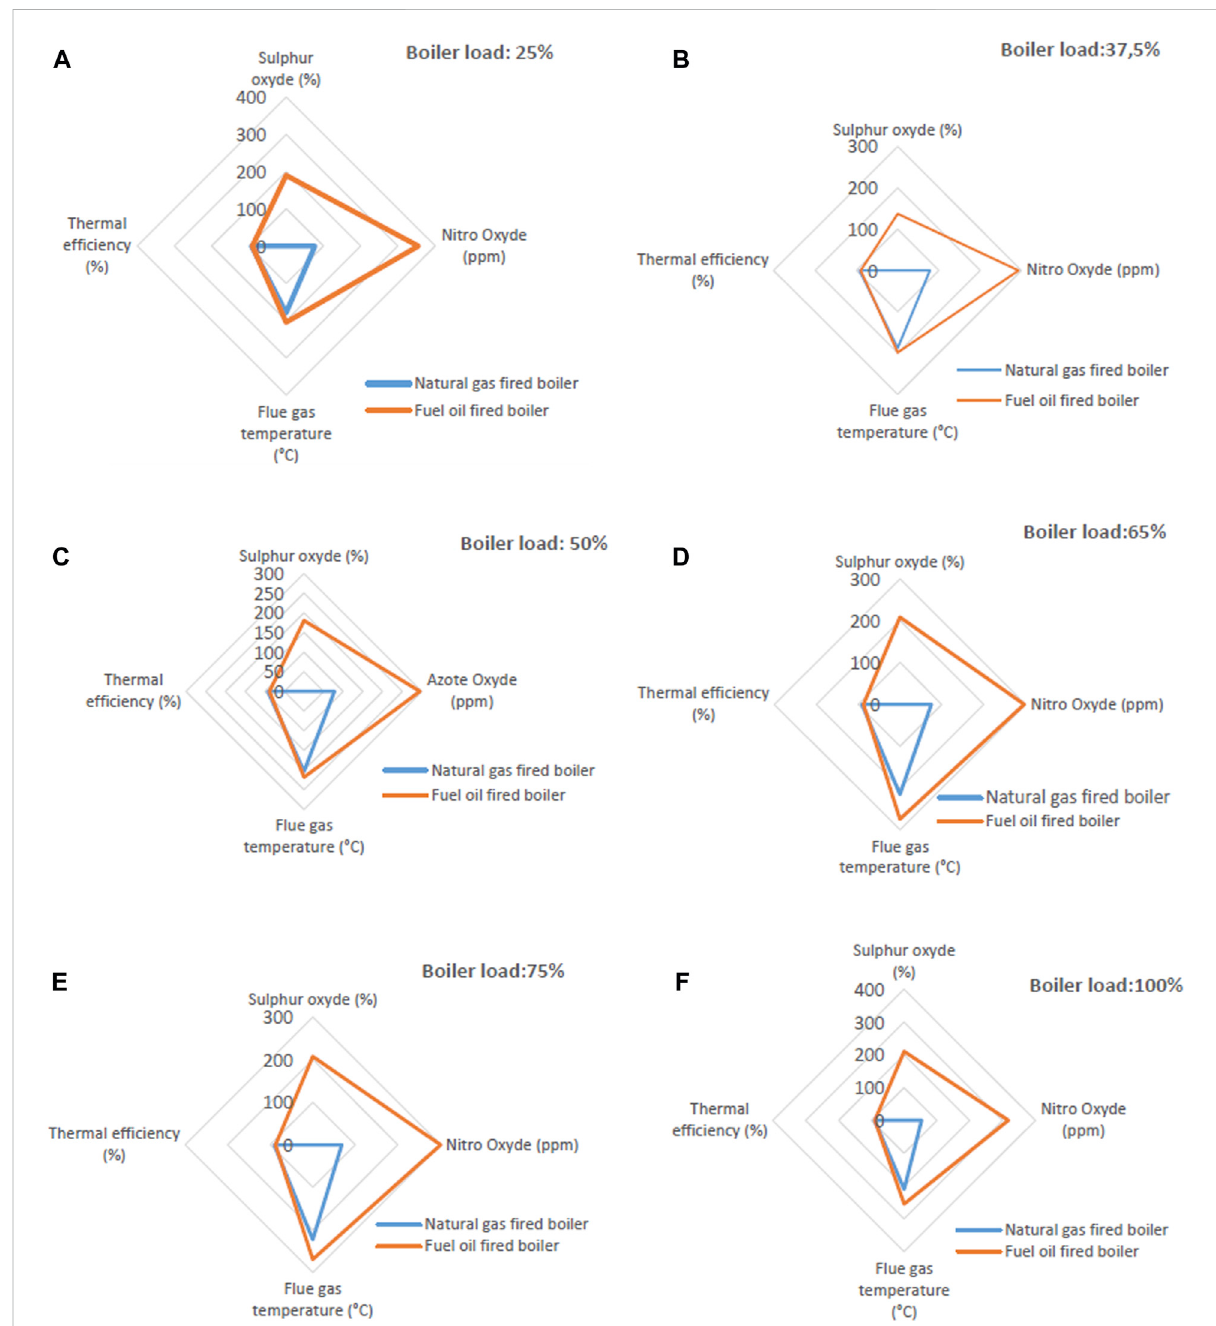
FIGURE 13 Comparison of nitrous oxide, sulfur dioxide, thermal ef fi ciency, and fl ue gas temperature in fuel fi ring or gas fi ring mode: (A) boiler load of 25%, (B) boiler load of 37.5%, (C) boiler load of 50%, (D) boiler load of 65%, (E) boiler load of 75%, (F) boiler load of